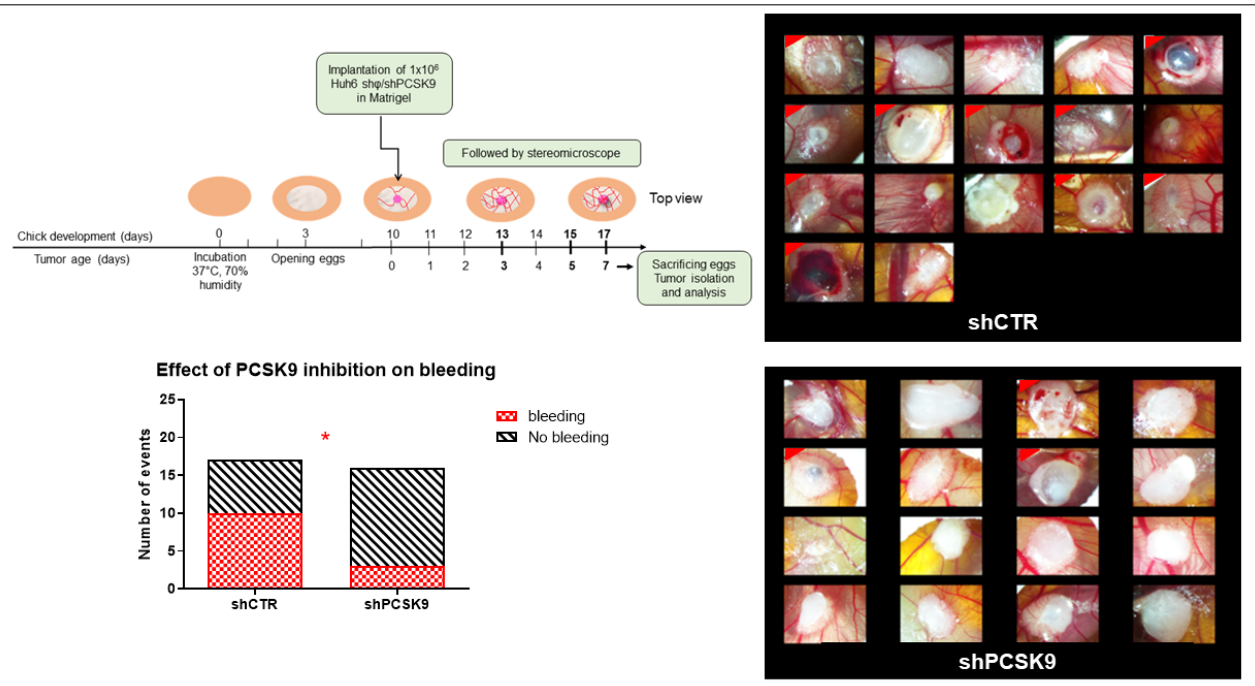
Figure 7. Depleting PCSK9 impairs liver tumor development in vivo. CAM model: Huh6 cells were grafted on the chicken CAM. Tumor growth was monitored on fixed tissues at day 7 after taking the photographs of tumors. The number of CAMs with tumor presenting (labeled with red corner) or not bleeding in CTR versus shPCSK9 is shown in histograms. Two-sided Fisher’s exact test, *: p < 0.05.